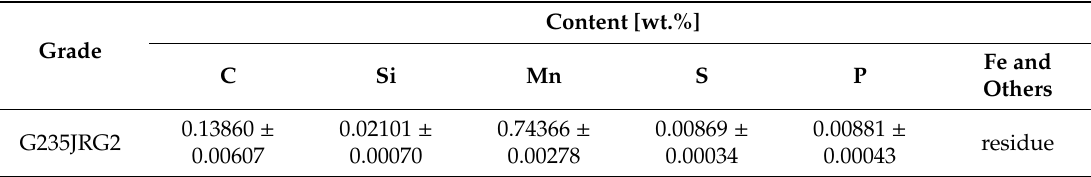
Table 2. The chemical composition of G235JRG2